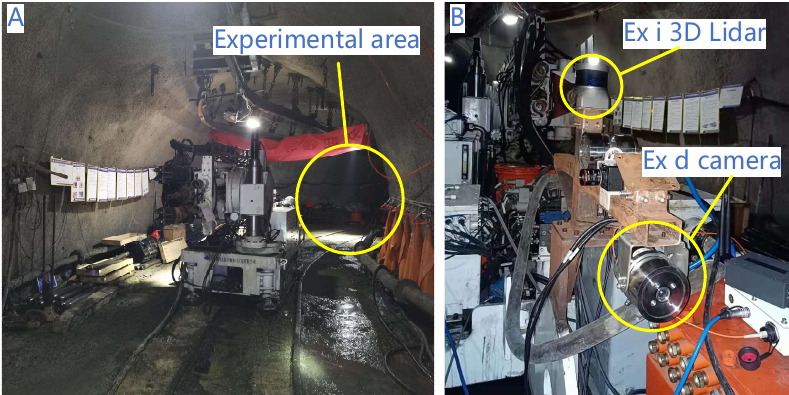
Figure 13. Field experiment in a coal mine roadway. ( A ) shows the roadway environment and the location of the drilling robot. ( B ) shows the location of the external sensors, which meet the underground explosion-proof requirements.